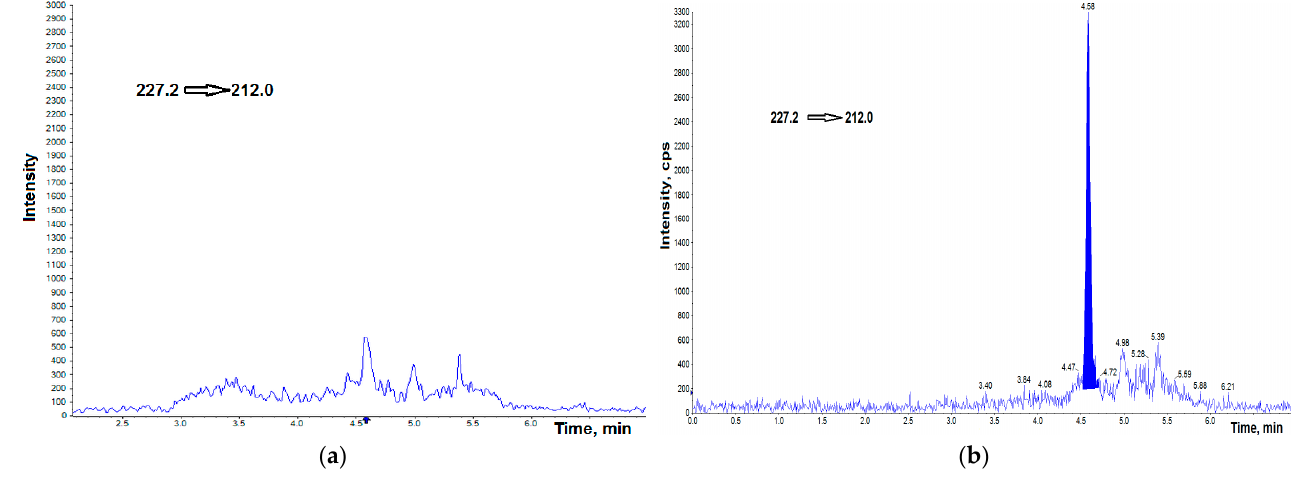
Figure 1. UHPLC–MS/MS chromatogram of BPA-free HA ( a ), BPA-free HA spiked with 0.25 ng g − 1 BPA ( b ). cps—counts per second.